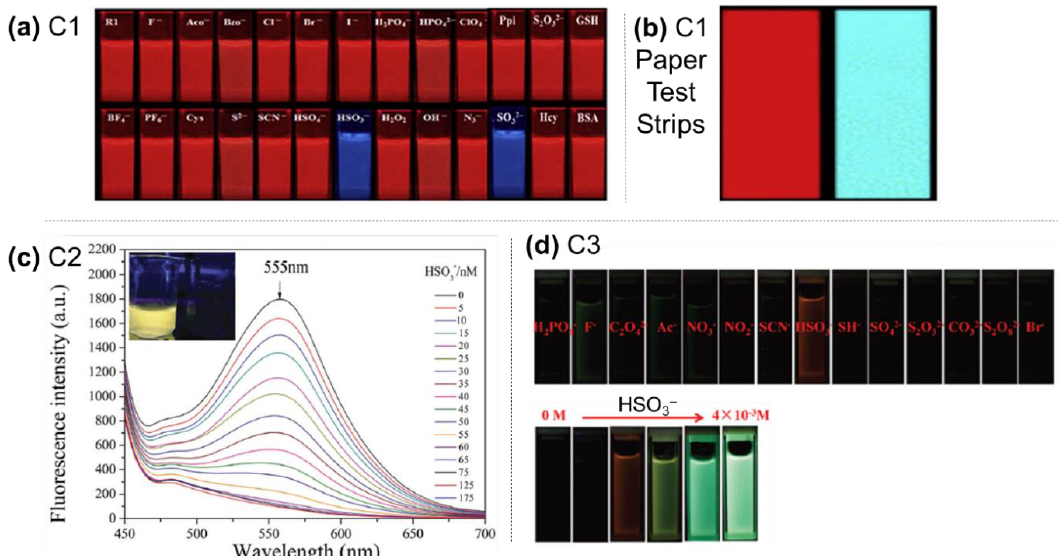
Figure 8. ( a ) Photos showing the selective emission colour change of C1 solution due to HSO 3 − and SO 32 − . ( b ) Photos showing emission change of C1-coated paper test strips on exposure to HSO 3 − . Reproduced with permission from [89]. Copyright 2016, Elsevier B. V. ( c ) Spectrofluorometric